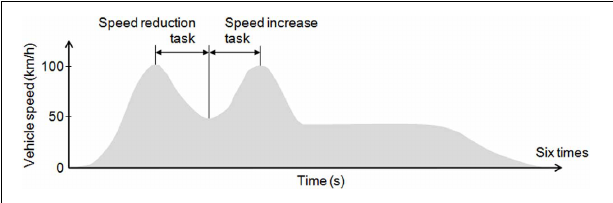
FIGURE 1 | Experimental tasks. Each subject performed 6 daytime trials and 6 nighttime trials on the experimental course. The tasks included a speed reduction task of deceleration from 100 to 50km/h and a speed increase task of acceleration from 50 to